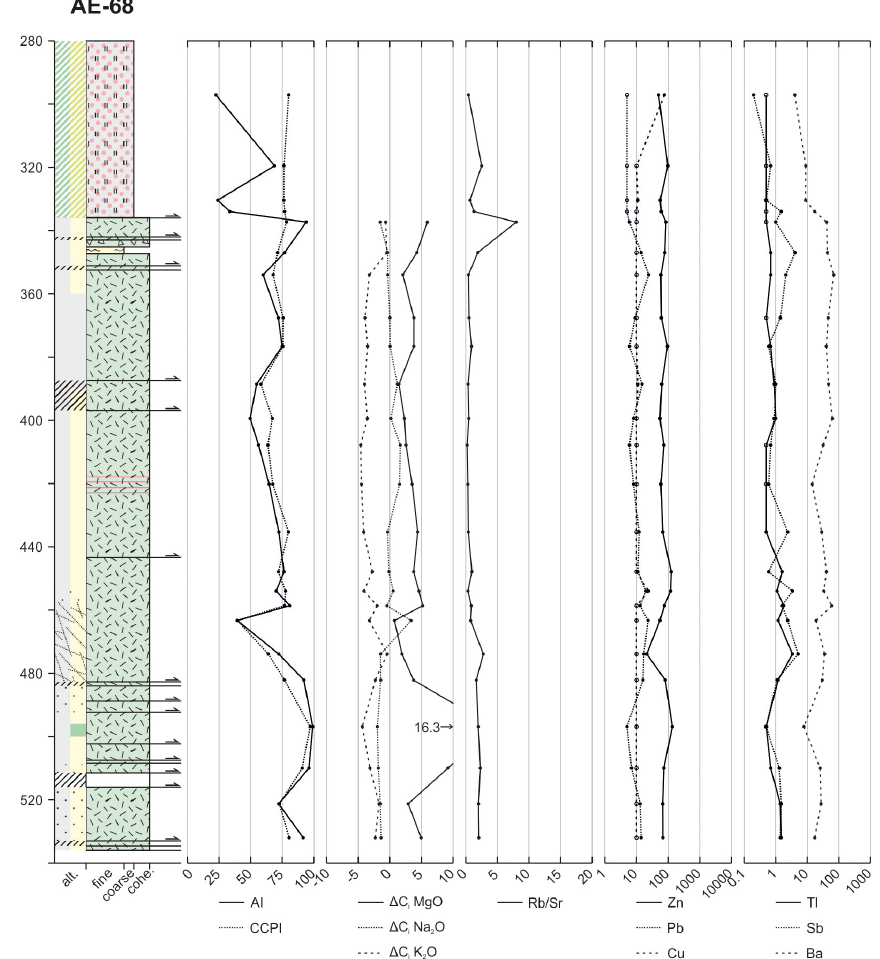
Figure 11. Diagrams showing the lithology, alteration assemblages, and whole rock geochemistry of analysed samples. Depth along drill cores is in metres. The AI (alteration index) and CCPI (chlorite–carbonate–pyrite index) are in percent. (cid:49) C i MgO, (cid:49) C i Na 2 O, and (cid:49) C i K 2 O are in weight percent (wt%). Trace element contents are in micrograms per gram (µgg − 1 ). Empty circles indicate element contents below the detection limit, which is the marked